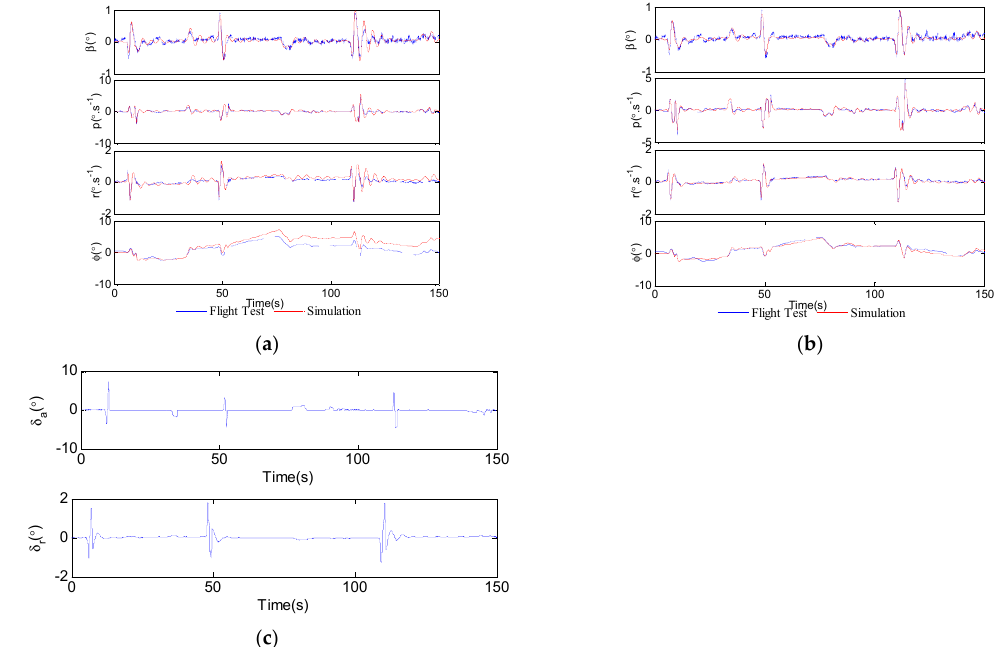
Figure 15. Mathematical simulation validation of the identification result. ( a ) Responses of recon- structed model based on MLE identification results; ( b ) Responses of reconstructed model based on DSMA identification results; ( c ) Aileron and rudder deflection data.